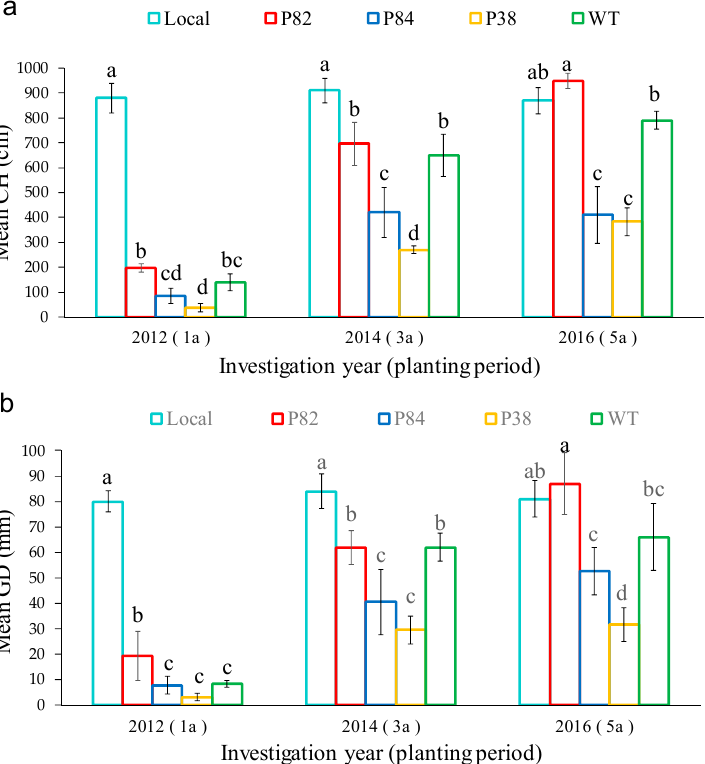
Figure 3. Comparison of mean culm heights (CH) ( a ) and ground diameter (GD) ( b ) to new culm of some D. latiflorus lines. (1a), (3a), and (5a) represent the year after cultivation, respectively. Mean ± SD (n = 3). Different letters indicate significant differences at p < 0.05 level.